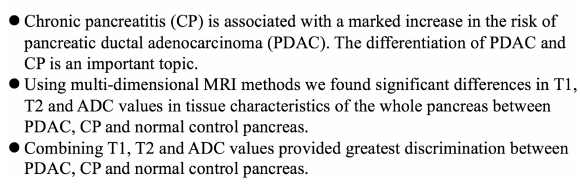
FIGURE 9 | The key points about this